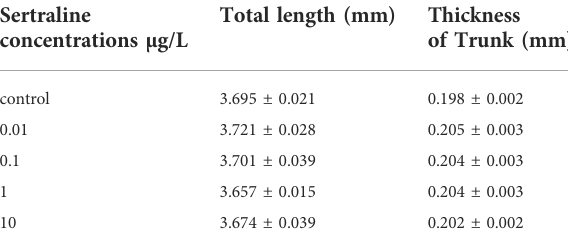
TABLE 4 Total length (mm) and trunk thickness (mm) of larvae exposed to different sertraline concentrations during development (4hpf-8dpf). Data are represented as mean ±